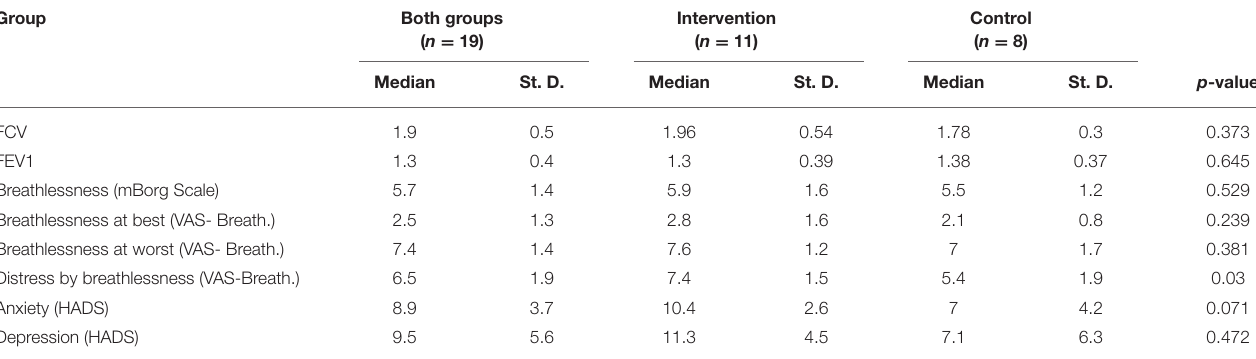
Intervention ( n = 11)